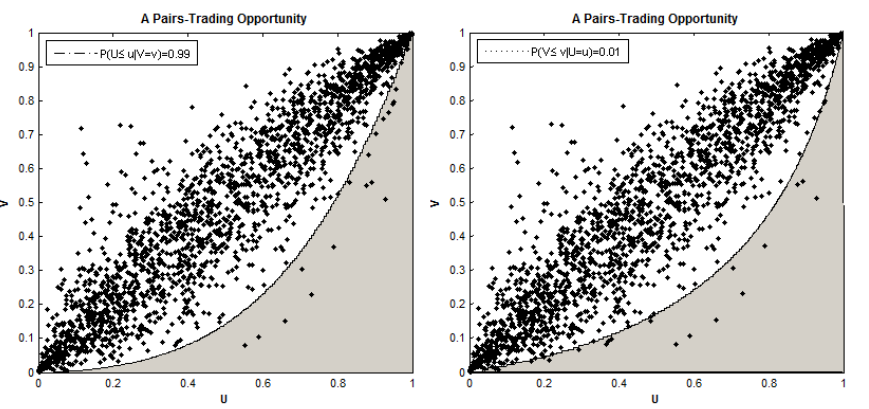
FIGURE 2: An illustration of the areas where the values of U and V respectively are considered extreme when using a 99% confidence level and the N14 copula dependence